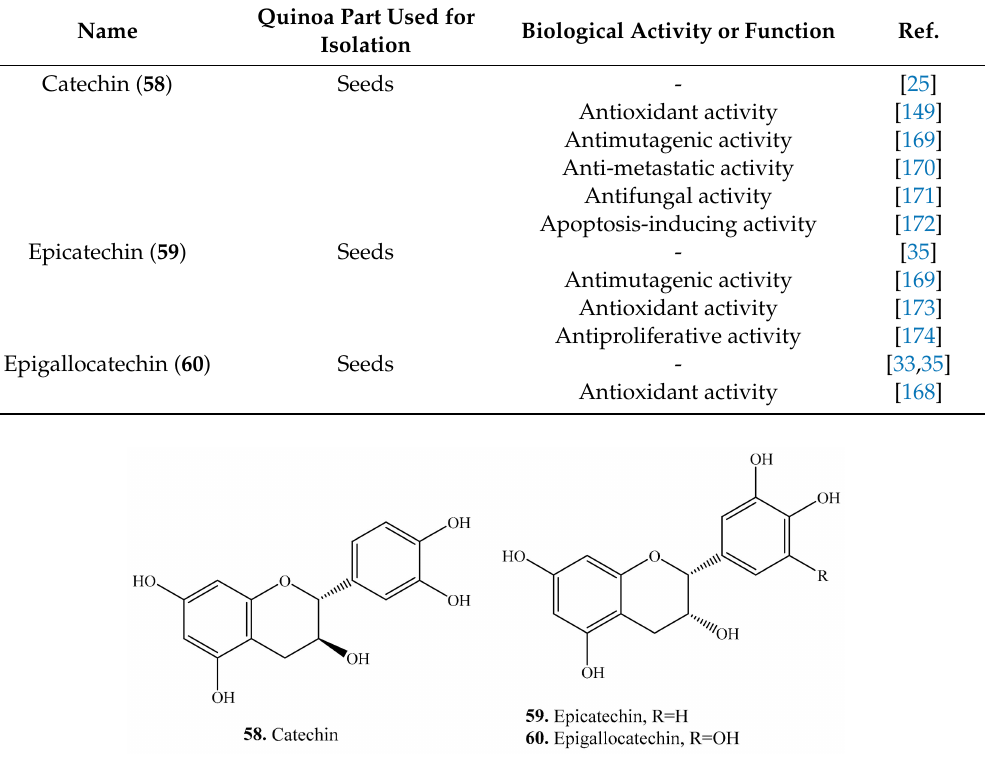
Figure 6. Structures of the flavanols isolated from quinoa.